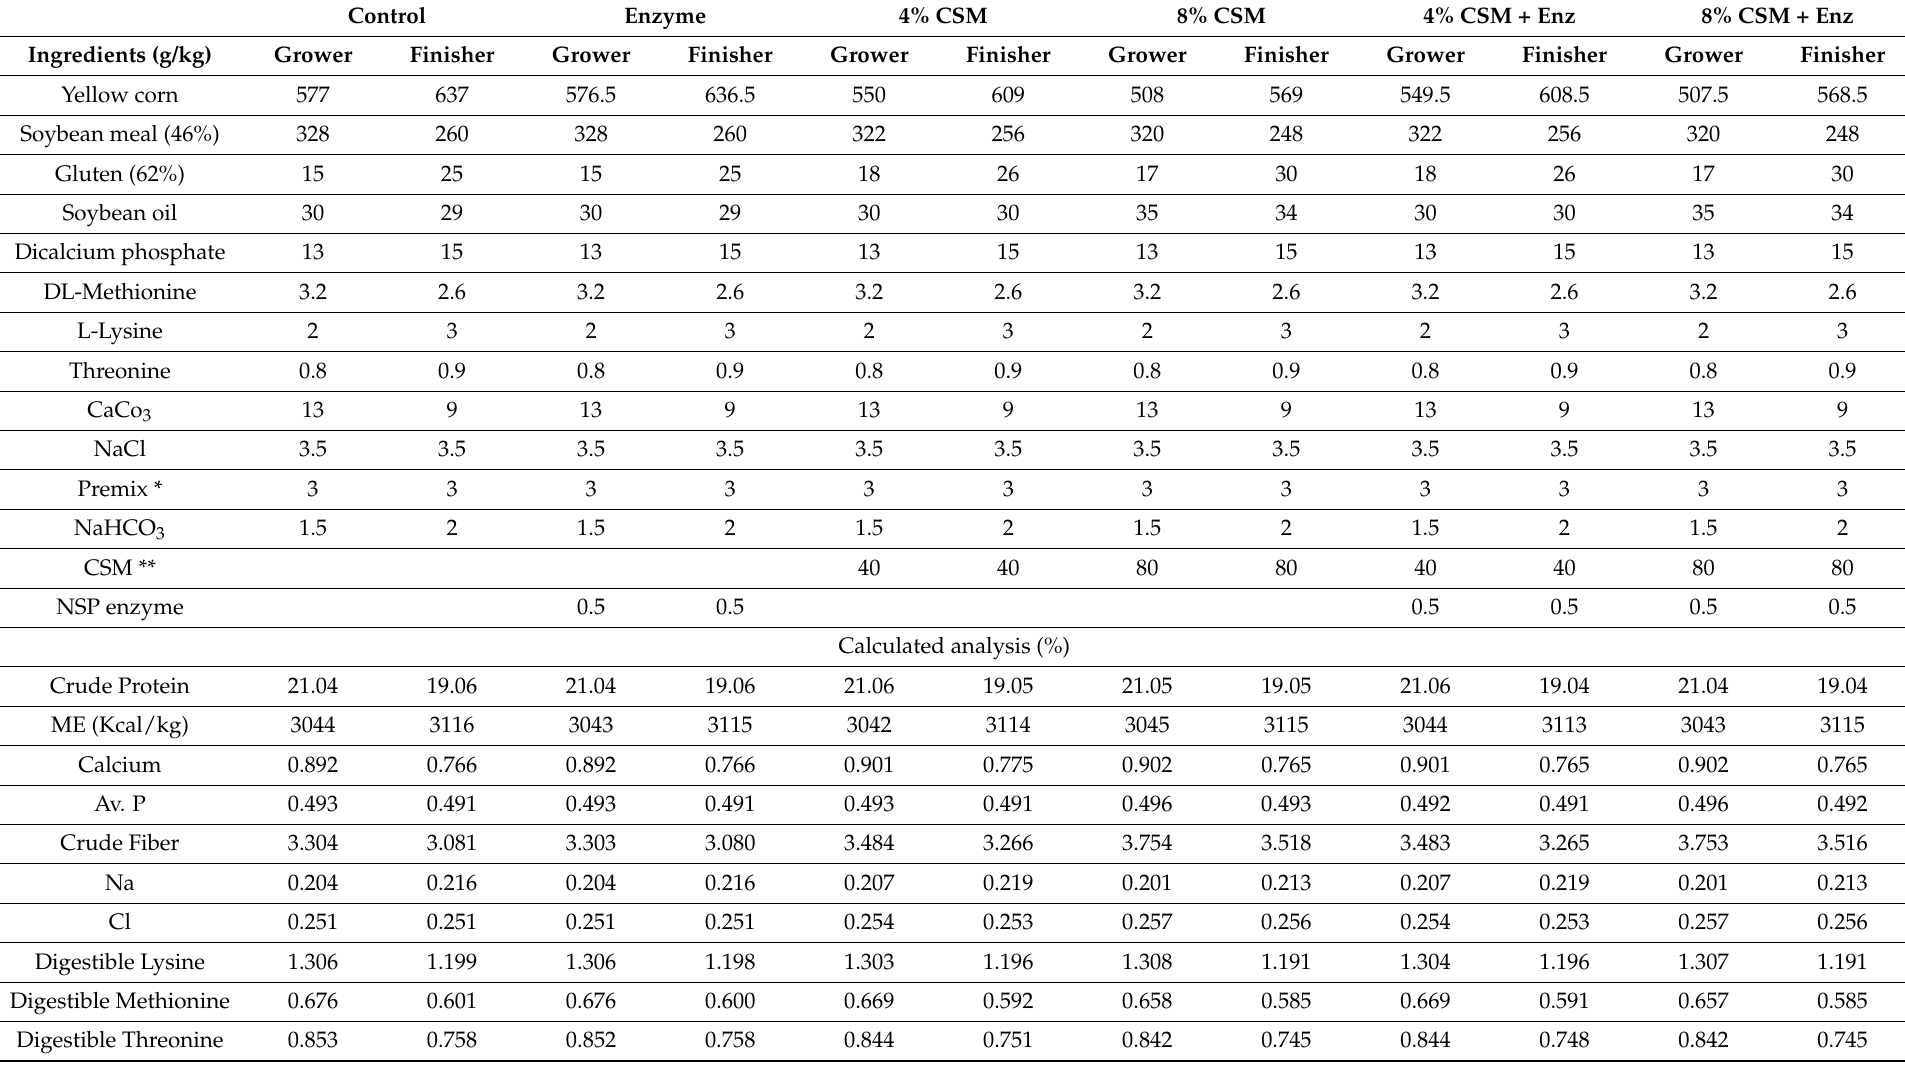
Table 1. Composition of the experimental